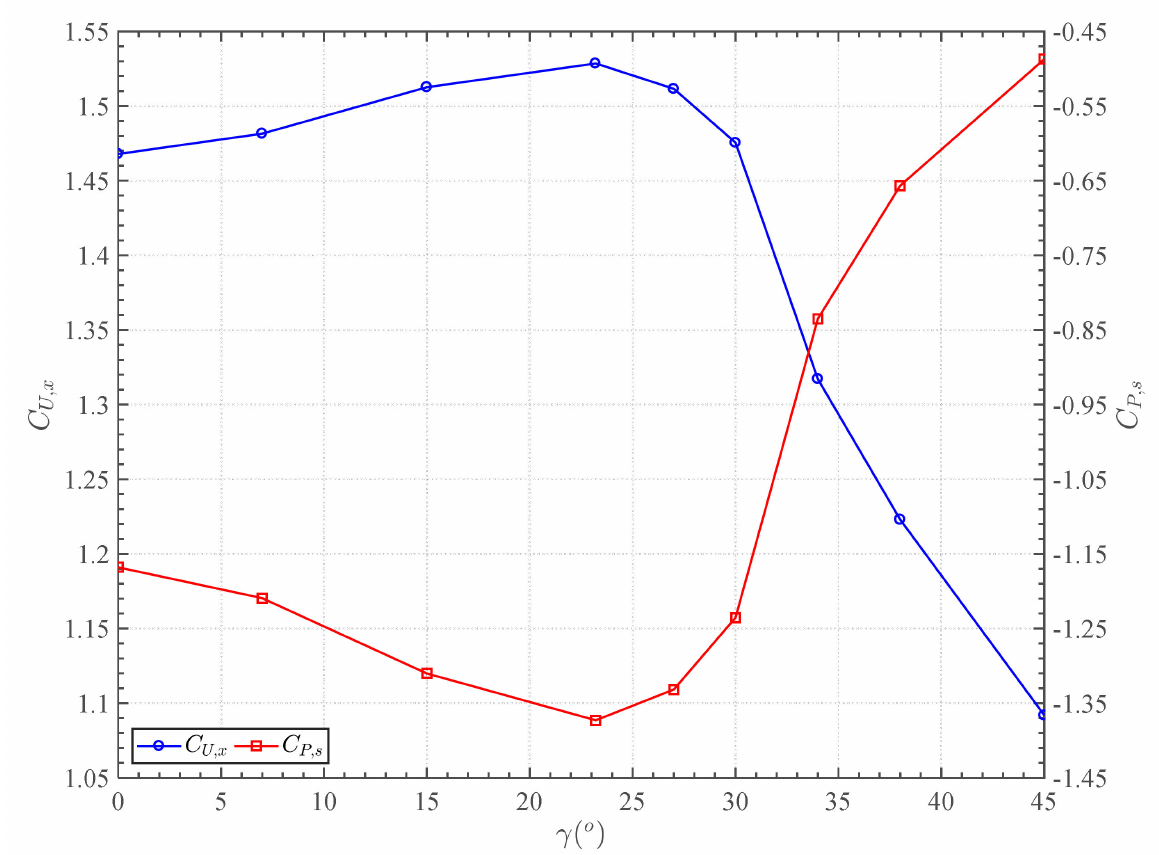
Figure 11. Evaluation of the throat axial velocity coefficient ( C U , x ) and static pressure coefficient ( C P , s ) with yaw bearing ( γ ) within a free-stream velocity ( U ∞ ) of 4 m.s − 1